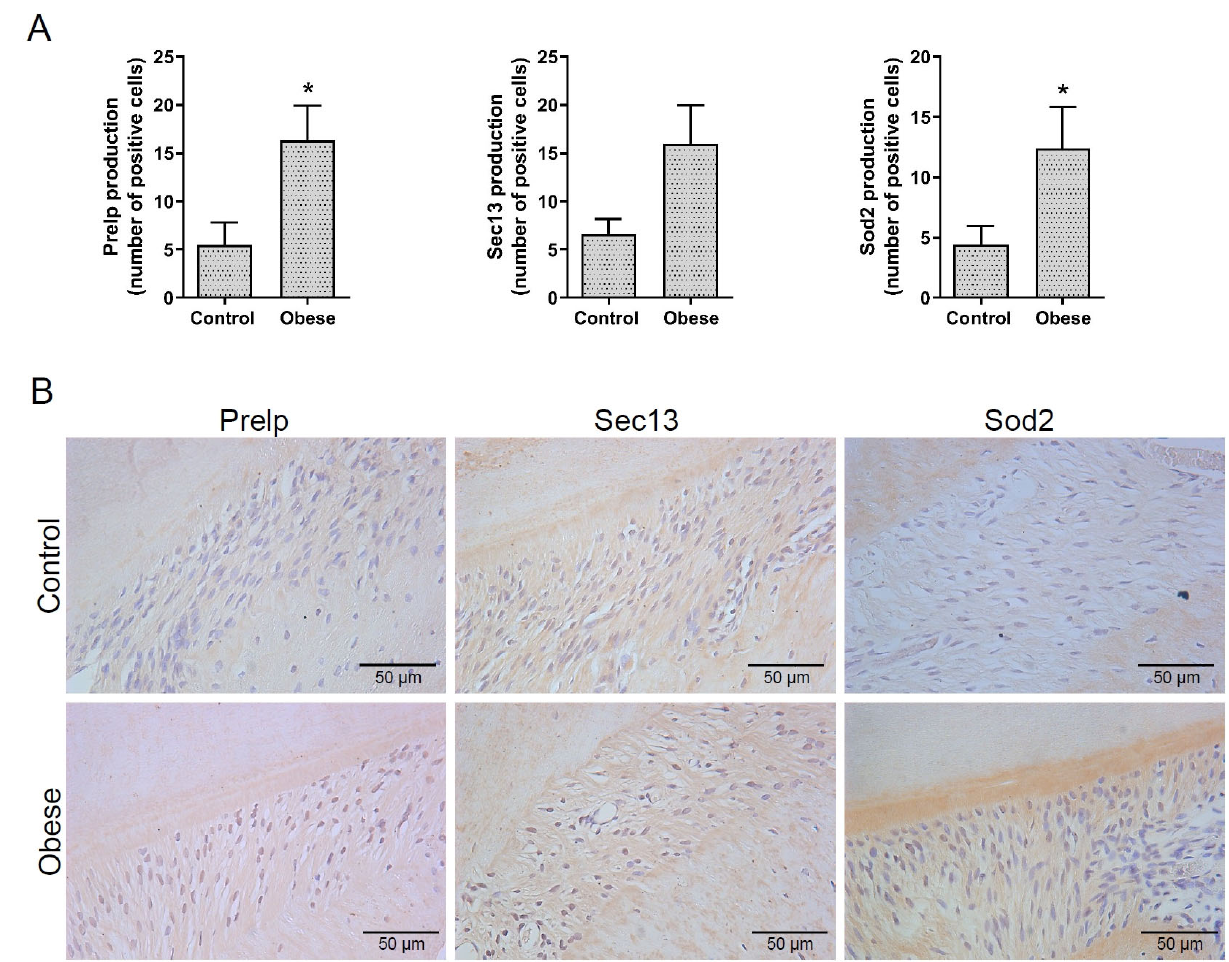
Figure 6. ( A ) Graphs with mean and standard deviation showing the number of cells positive to Prelp, Sec13, and Sod2, as analyzed by IHC staining ( p < 0.05). * Significant ( p < 0.05) difference. ( B ) Representative images (400× magnification) of IHC staining for Prelp, Sec13, and Sod2 proteins, respectively, in tissue sections from the control and obese groups.